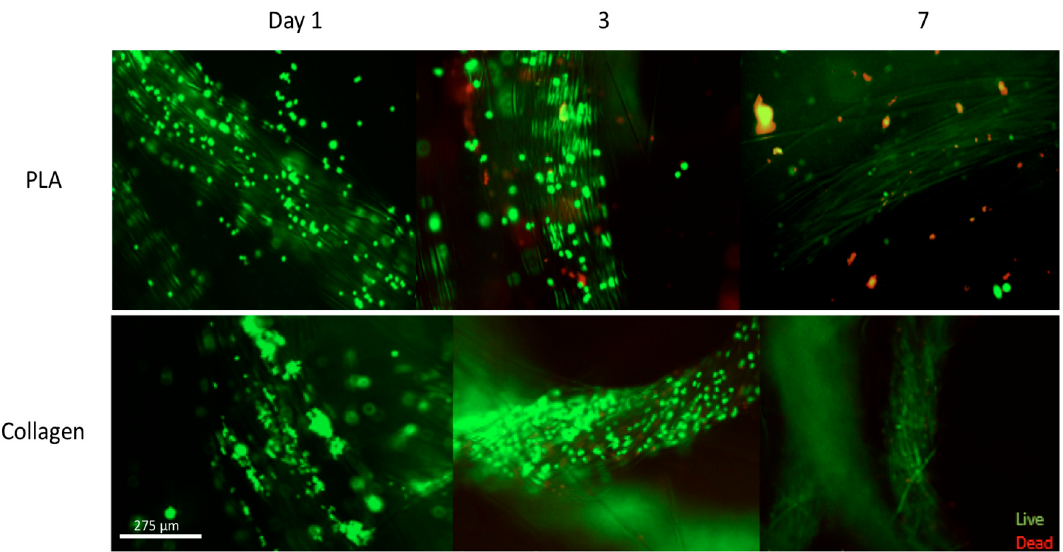
Figure 3. Representative Live/Dead Images of Collagen and PLA samples. Images were acquired at days 1, 3, and 7 for both samples. Live cells appear green and dead cells appear red. Scale bar = 275 μ m.